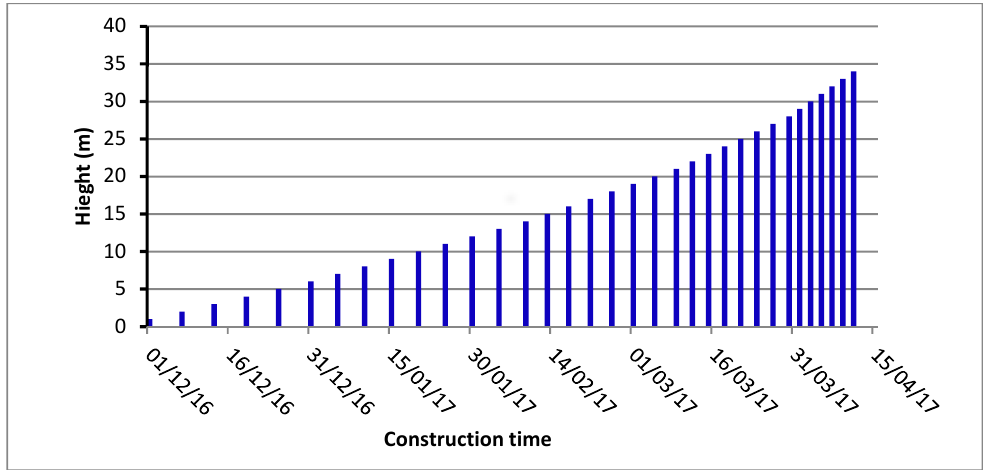
Figure 2. Construction progress of the highest block of Al-Khanaq dam.